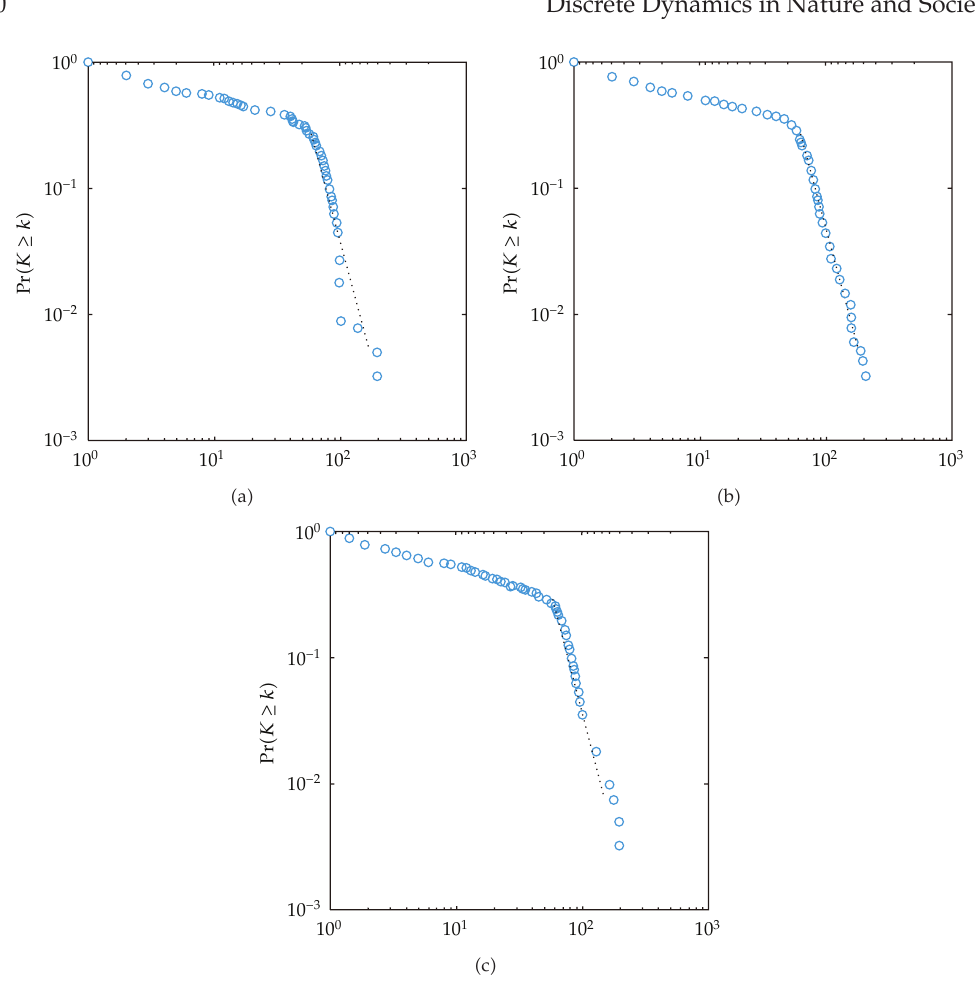
Figure 4: The cumulative distribution function Pr (cid:5) K (cid:6) and their straight line power-law fits of the node degree of China Domestic airline network at year 2000, 2005,